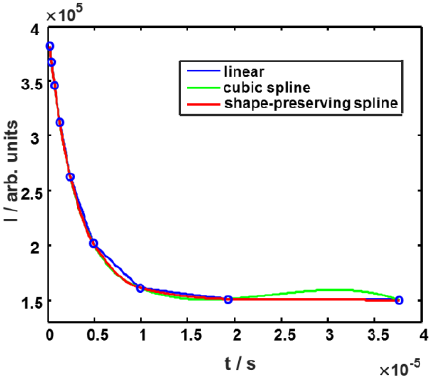
Fig. 4: Local signal approximations used to reconstruct measured signal.